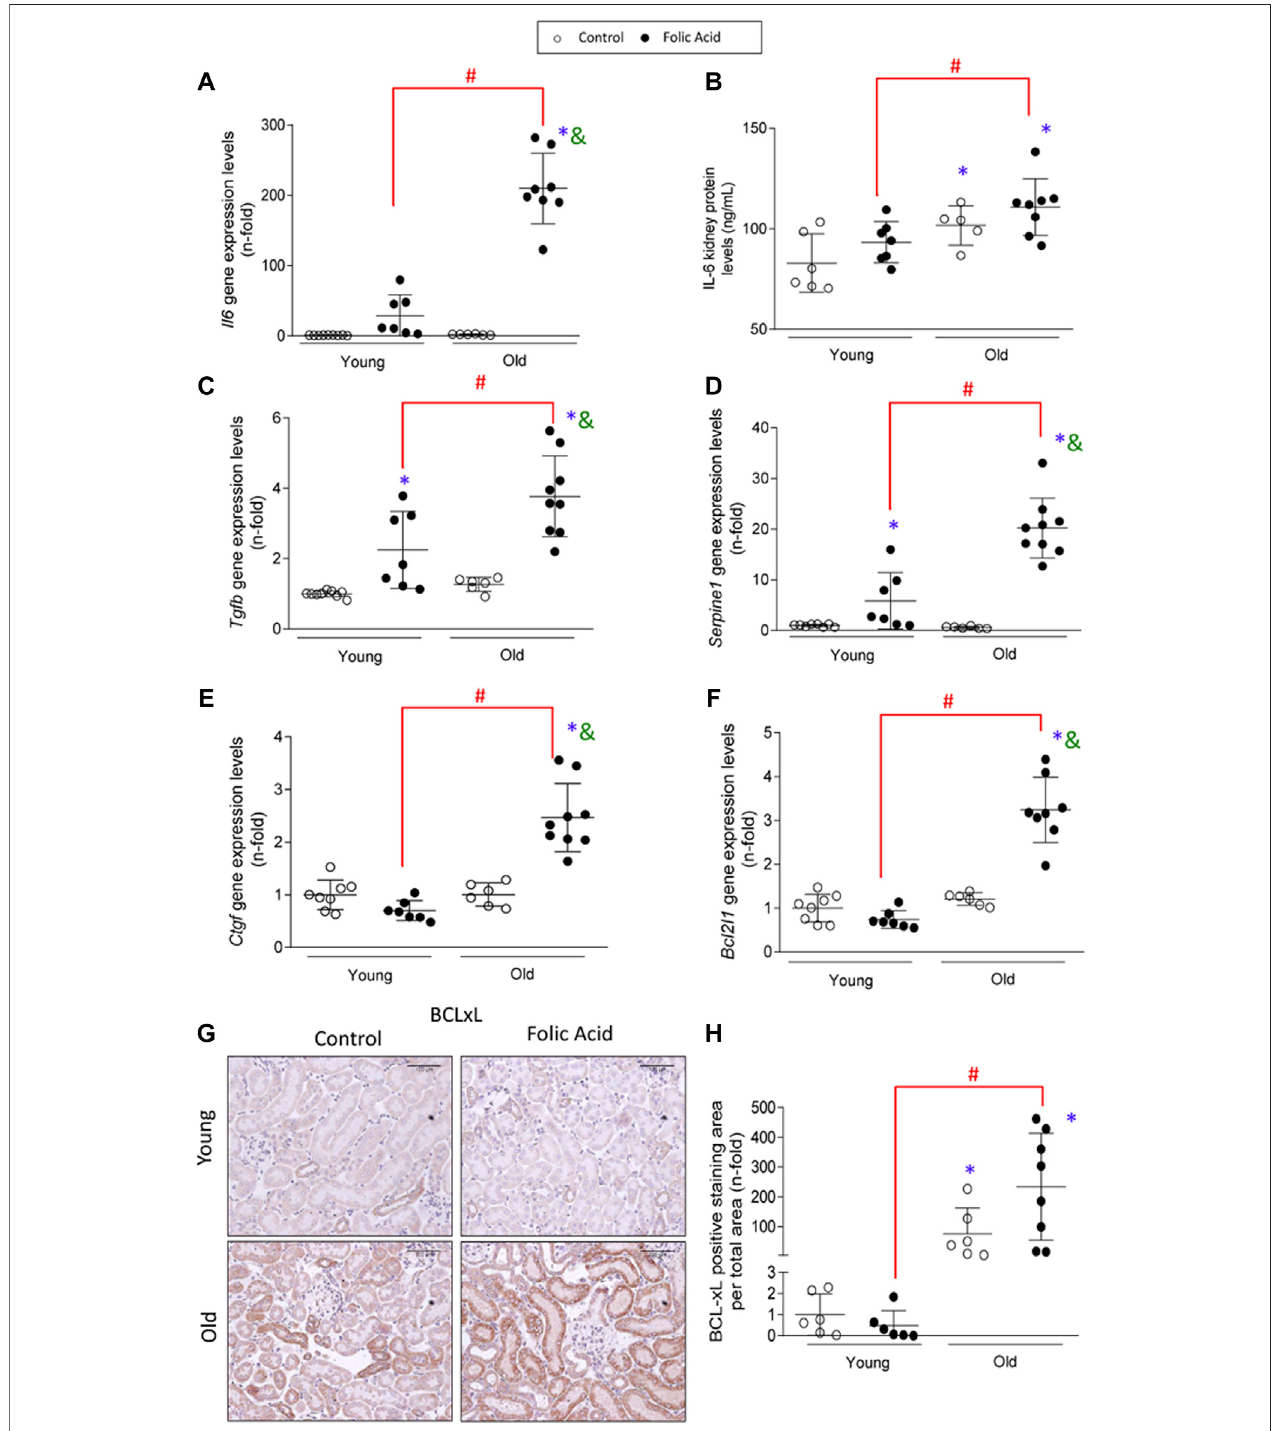
FIGURE 8 | Increased expression of senescence-associated secretory phenotype components (SASP) and anti-apoptotic proteins in old injured kidneys. Folic Acid (FA; 125 mg/kg) was injected in 3-months-old (Young) and 1-year-old (Old) C57BL/6 mice and kidneys were studied after 48 h. Gene expression levels of Il6 (A) , Tgf β (C) , Serpine1 (D) , and Ctgf (E) were determined by qRT-PCR. (B) Total protein of renal extracts of IL-6 were evaluated by ELISA. (F) Gene expression levels of Bcl2l1 were evaluated by qRT-PCR. (G, H) BCL-xL protein was evalated by immunohistochemistry. (G) Representative microphotographs of BCL-xL and (H) its quanti fi cation of stained area per total area. Data are shown as n-fold and expressed as mean ± SD of n (cid:2) 6 – 9 animals per group. * p < 0.05 vs. control young mice, # p < 0.05 vs. FA-injected young mice, & p < 0.05 vs. control old mice. The parametric one-way ANOVA statistical test was performed, except for the BCL-xL quanti fi cation, in which a non-parametric Kruskal-Wallis statistical test was conducted.